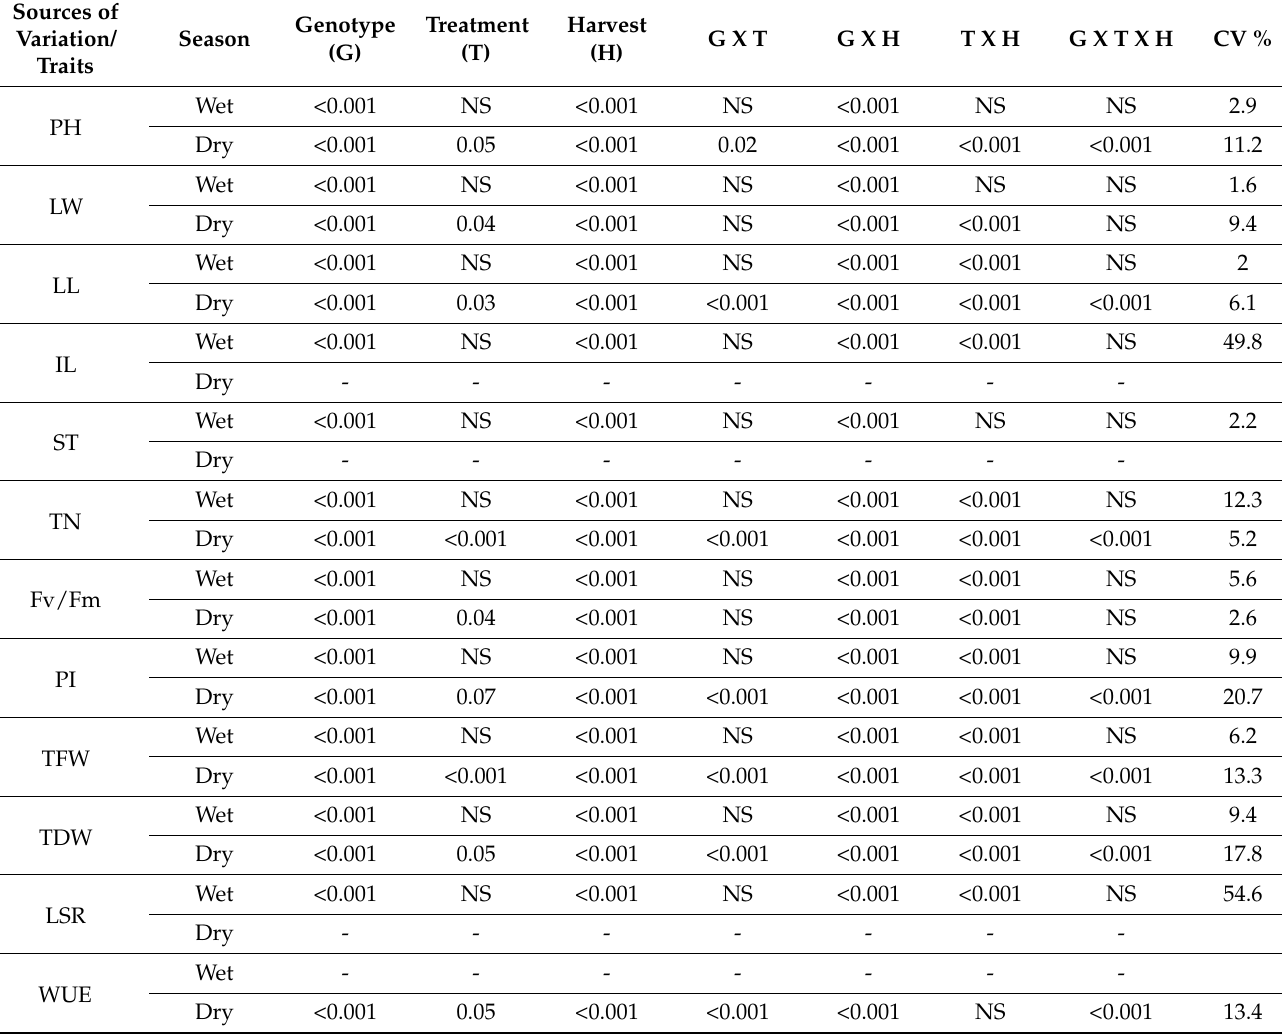
Table 1. Combined ANOVA for agro-morphological traits of 84 Napier grass genotypes tested under rainy (wet) and dry (dry) season